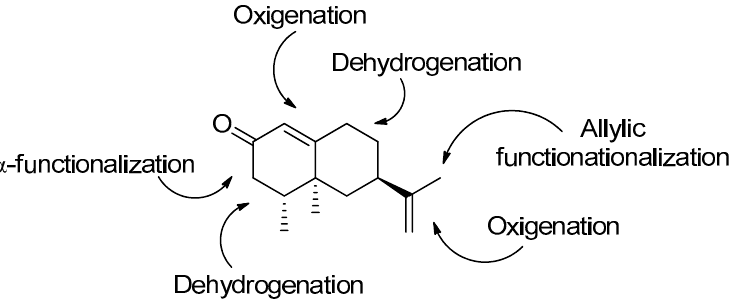
Figure 1. Generation of structural diversity from nootkatone ( 1 ).